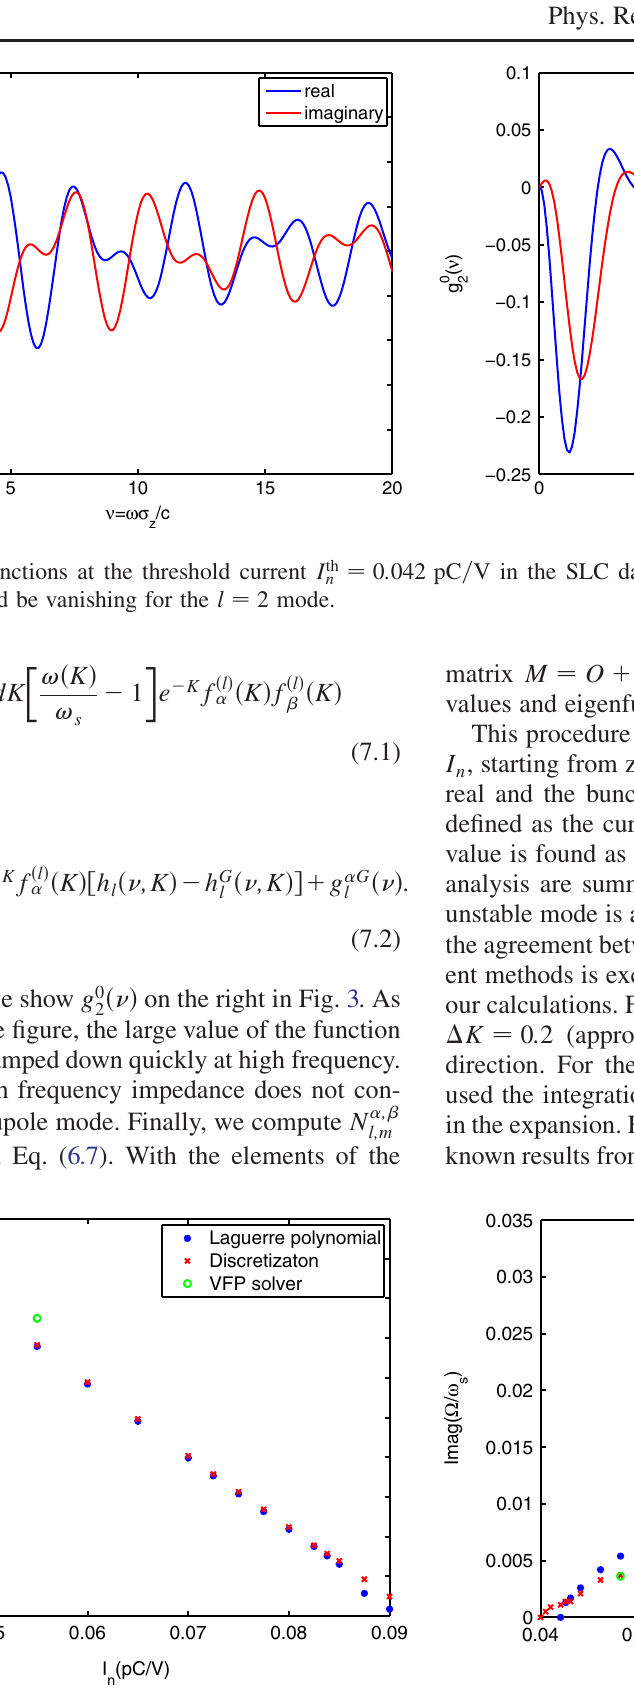
FIG. 4. Tune shift (left) and growth rate (right) of the most unstable mode in the SLC damping ring.